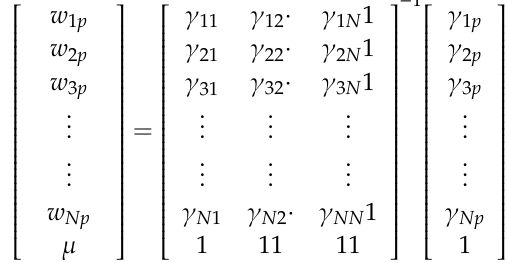
Figure 5. Sample semivariogram fitted with a spherical model based on data from Typhoon Morakot at 12:20 pm on August 9, 2009.